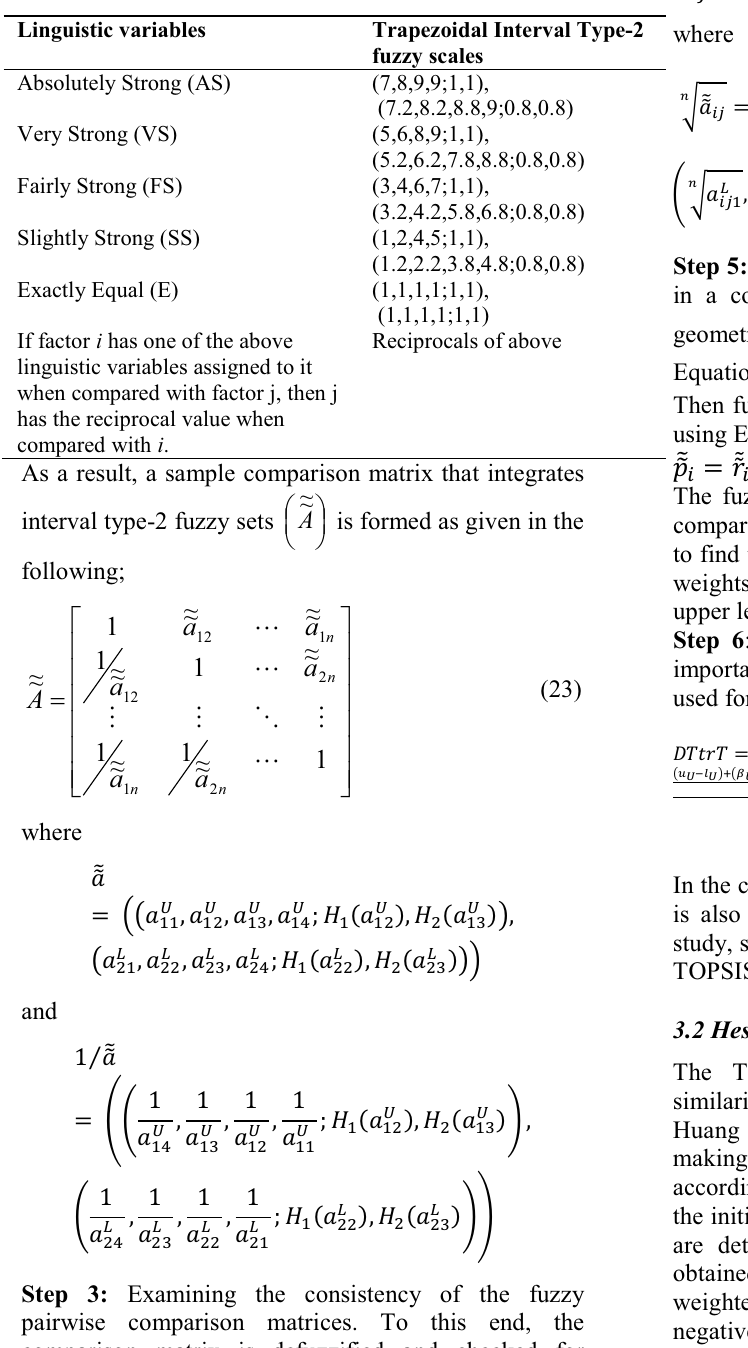
Table 4. Definition and interval type 2 fuzzy scales of the linguistic